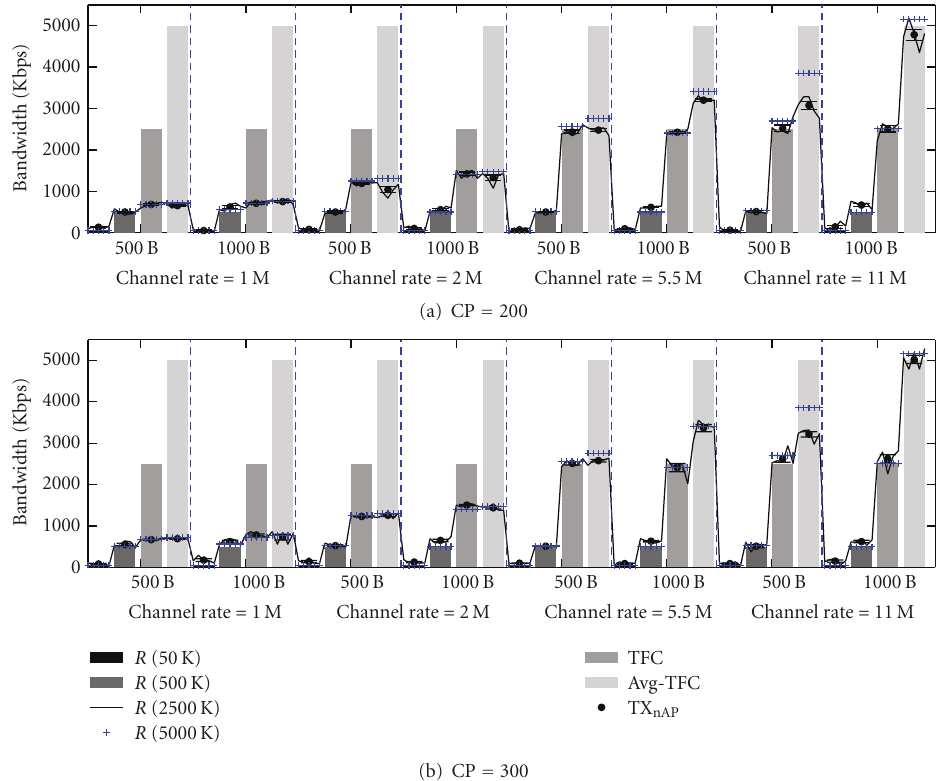
Figure 9: Case 1: comparison between estimated bandwidth with the TFC and AP’s actual transmission rate (TX nAP ) for n = 5.